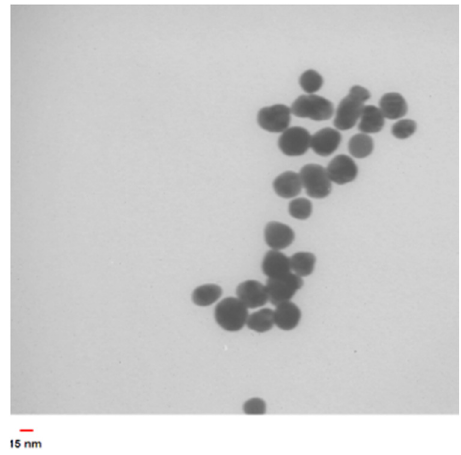
Figure 10: TEM image of the synthesized Au NPs using optimal